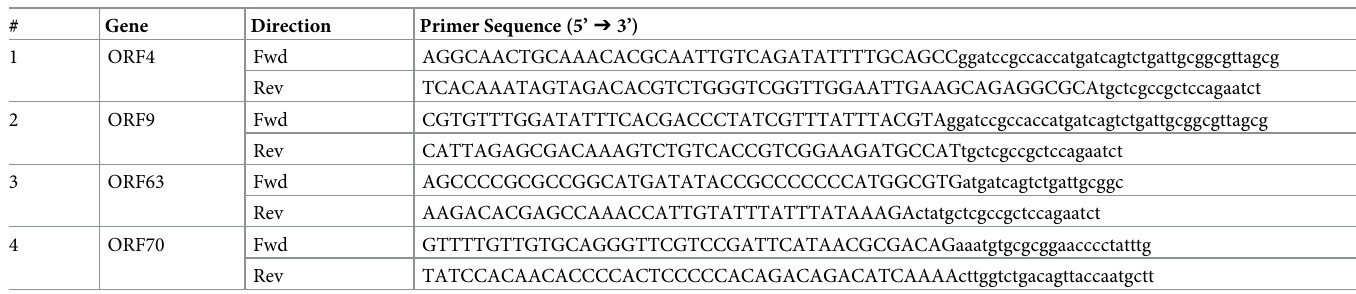
Table 1. Primer design for VZV BAC recombineering.